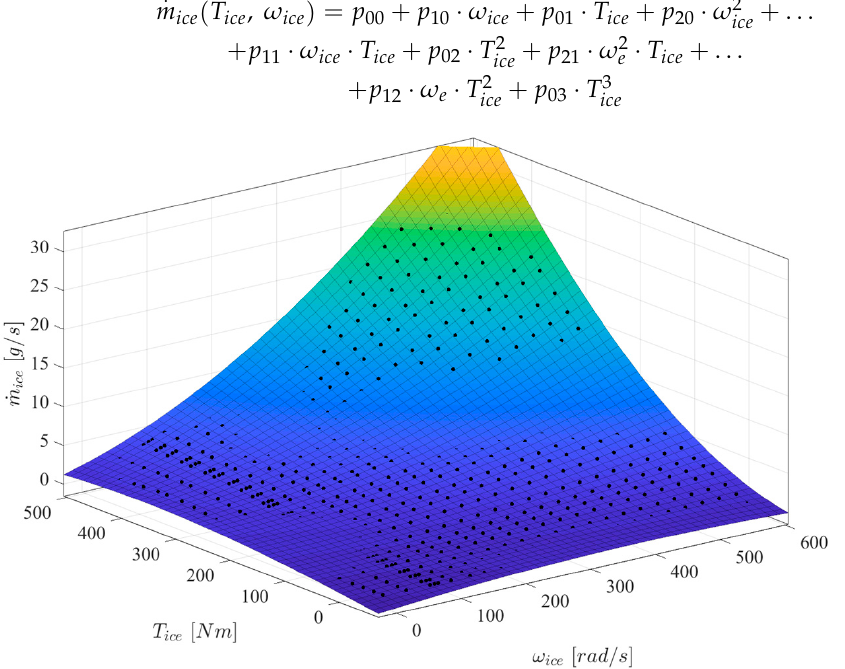
Figure 10. Points of the fuel rate as a function of engine torque and speed. The surface represents the curve fitting with a polynomial equation.